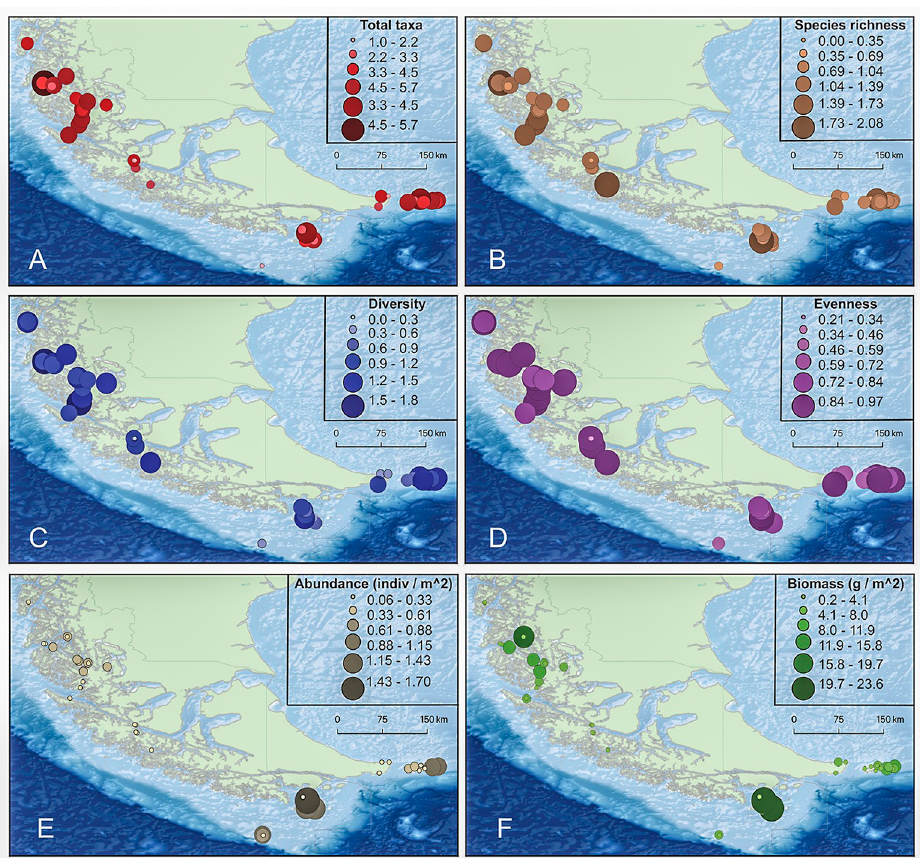
Fig 3. A. Total taxa, B. Margalef species richness, C. Shannon-Weiner Diversity, D. Pielou’s Evenness, E. Abundance, F. Biomass between locations. Boxes represent 25th, median and 75th percentiles, and upper and lower quartiles. Basemap derived from GEBCO Compilation Group (2020) GEBCO 2020 Grid (doi:10.5285/a29c5465-b138-234de053- 6c86abc040b9). Processing and assembly of the Global Self-consistent, Hierarchical, High-resolution Geography Database for shoreline data from